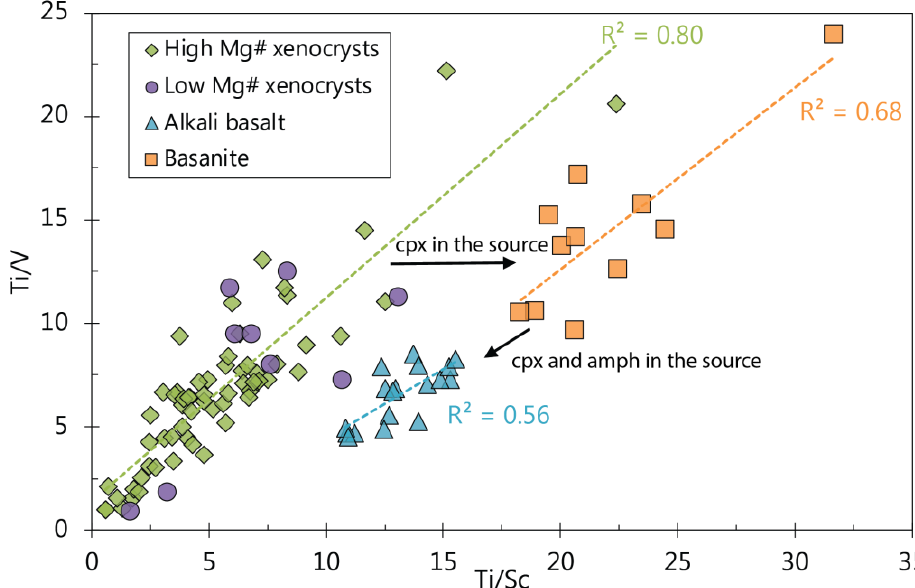
Figure 9. Olivine Ti / V plotted against Ti / Sc. Cpx—clinopyroxene derived from the reaction between mantle peridotite and infiltrating carbonatite melt. Cpx and amph—clinopyroxene and amphibole from the reaction between mantle peridotite and an infiltrating carbonatite melt.